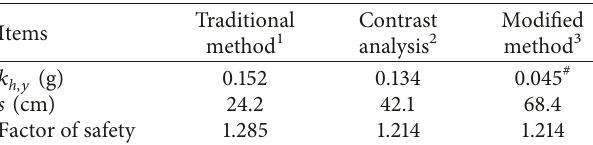
Table 6: Horizontal critical acceleration, sliding displacement, and factor of safety.